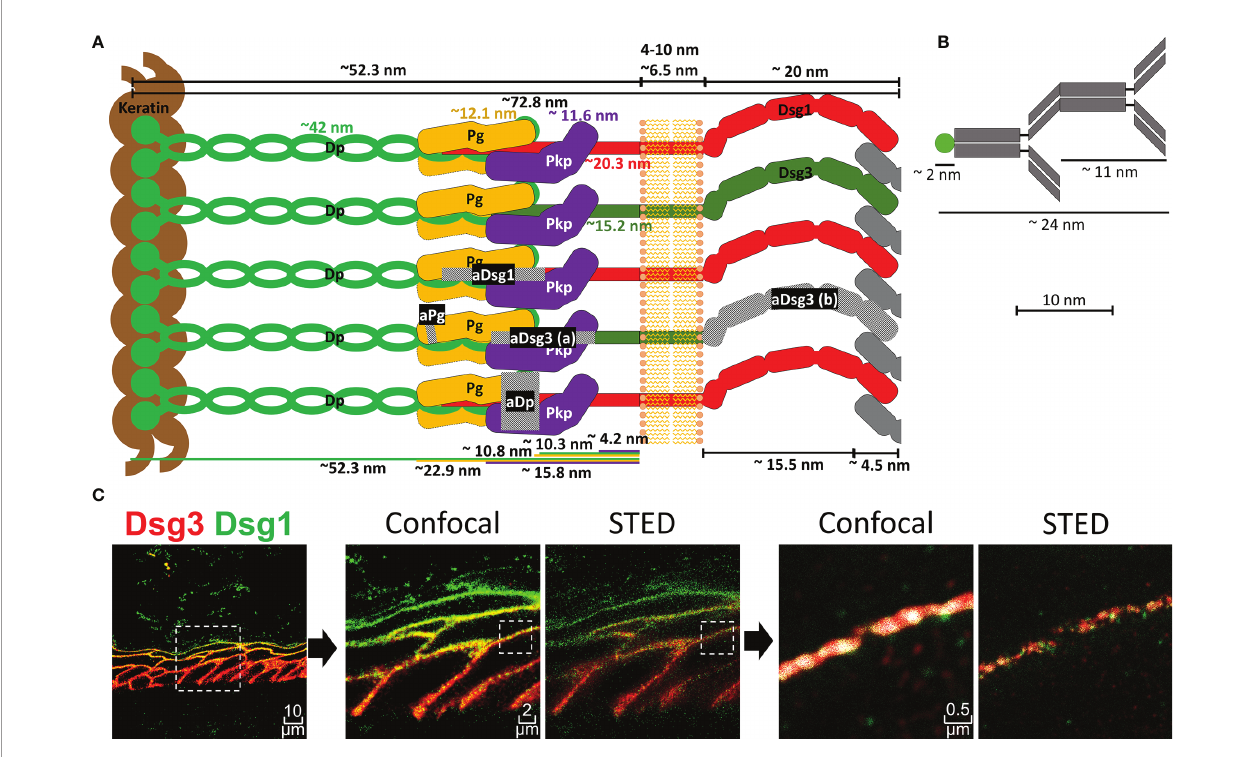
FIGURE 1 | (A) Schematic depiction of a desmosome unit sub-cell with all proteins shown to scale as indicated. Grey hatched areas mark regions against which antibodies used in this study were raised. aDsg3 (a) is a rabbit IgG and aDsg3 (b) a mouse IgG, as indicated in the materials and methods section. (B) Depiction of a primary and dye coupled secondary antibody complex for scale. (C) on the right is an overview of a Dsg1 (green)-Dsg3 (red) staining with 3x zoom and 15x zoom to a single cell border comparing the co-localization results using confocal images vs. super resolution STED images (squares with dotted borders mark the zoomed in